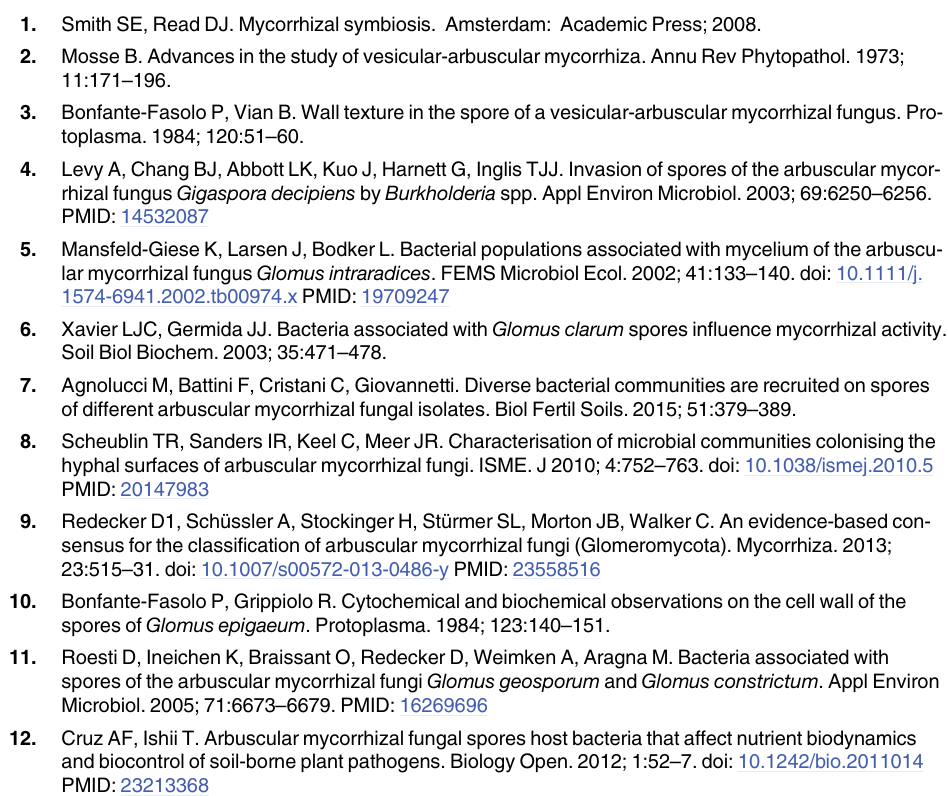
S1 Table. EC and spore count of the soil samples collected from Saemangeum reclaimed land. S2 Table. 18S rDNA sequencing morphologically differentiated spore used for isolation of spore associated bacteria. S3 Table. Number of SAB isolated from three different spores at different time intervals. S4 Table. Plant growth promoting (PGP) characters of spore associated bacteria